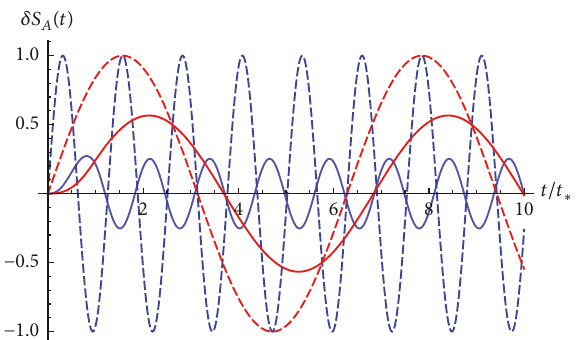
Figure 11: Entanglement entropy (solid line) as a function of time after a Floquet quench, plotted against the periodic source (dashed line). The colors blue and red denote frequencies Ω = {5, 1} , respectively. We have set 𝑑 = 3 , 𝜃 = 0.1 , and 𝑧 = 1.5